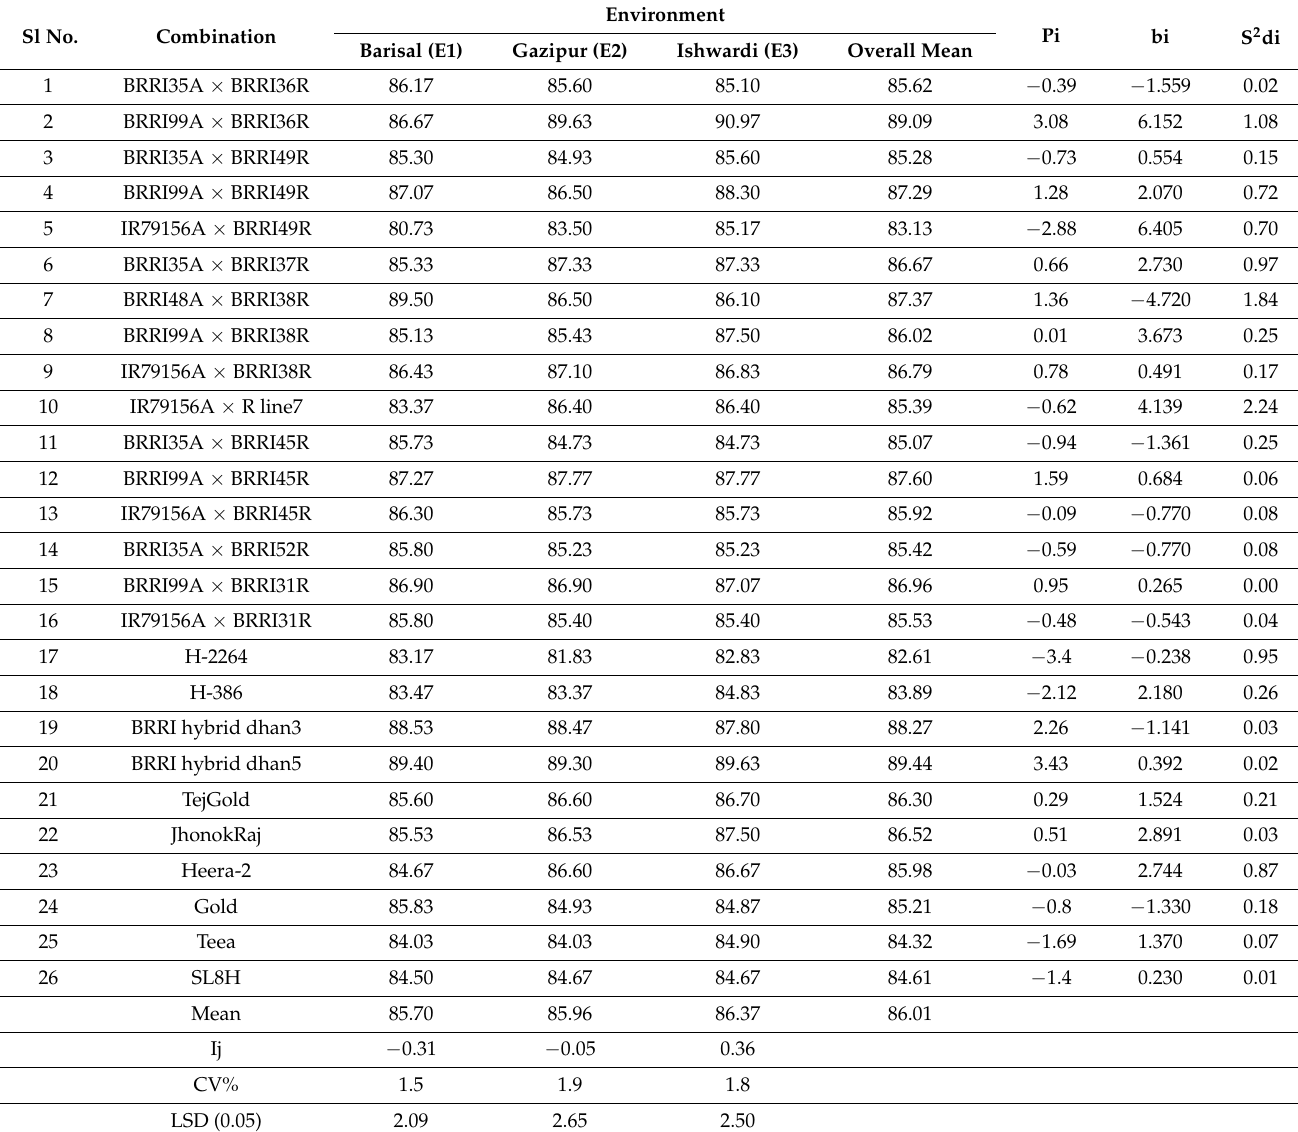
Table 7. Stability analysis for spikelet fertility percentage of 26 hybrid combinations at three